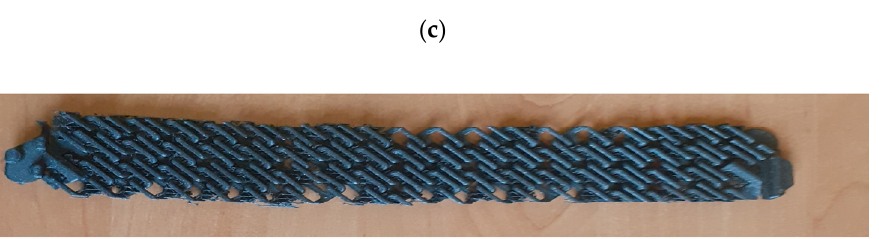
Figure 8. Printouts of the chainmail: ( a ) project, ( b , c ) real chainmail.